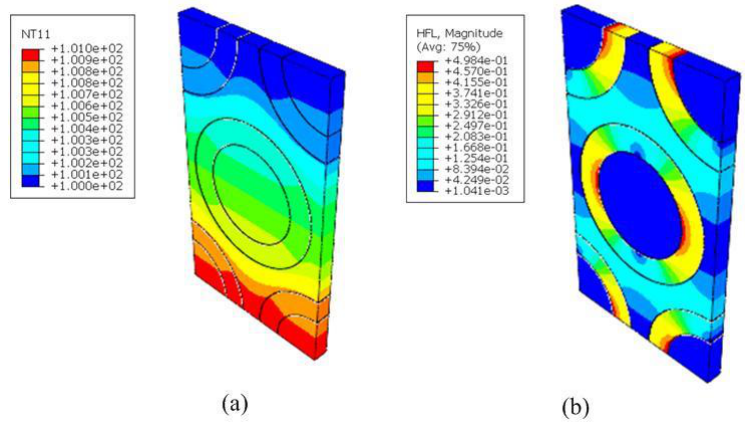
Figure 5. Distribution of the ( a ) temperature and ( b ) heat flow along the y − direction. Finally, the homogenized coefficients of RVE 2 were further transferred to RVE 3 to predict the effective response of plain-woven composites. The volume fraction of the fiber yarn in the model was v y = 55.2%. The parameters of the established geometric model are listed in Table 4. The FE analysis of RVE 3 was illustrated by taking v B = 10% in the matrix and the hollowness ratio in the RVE 2 as 30% (as shown in Figure 6). A total of 174,978 elements and 275,010 nodes were used. Table 4. Geometric model parameters of plain-woven composites. Parameter Length